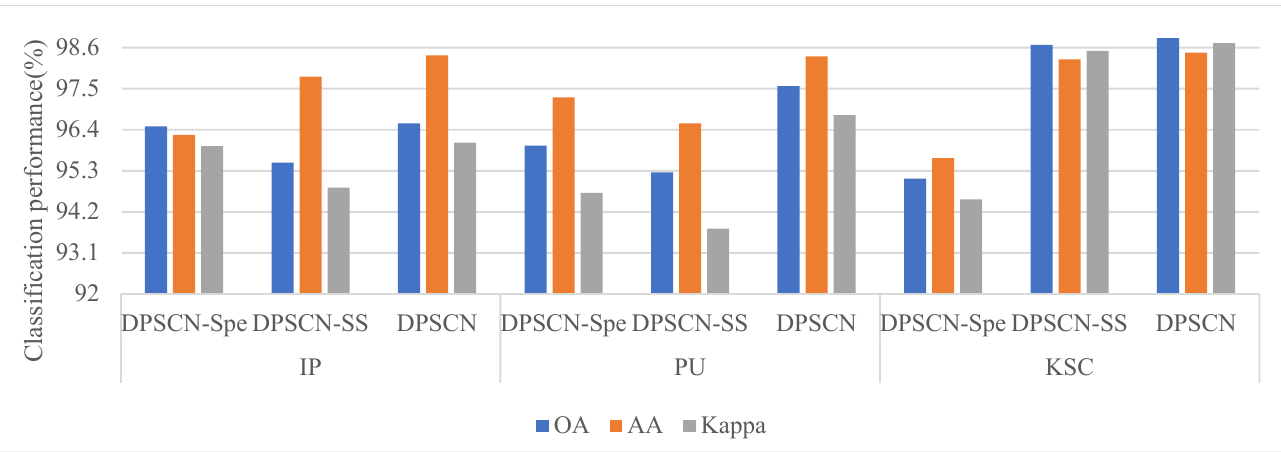
Figure 12. Classification performance of the classification network with the different feature learning block.